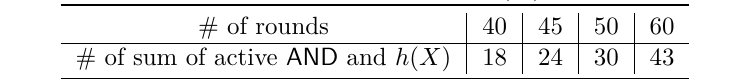
Table 1: The lower bound of the sum of AND and h ( X ) in the related IV setting. # of rounds 40 45 50 # of sum of active AND and h ( X )